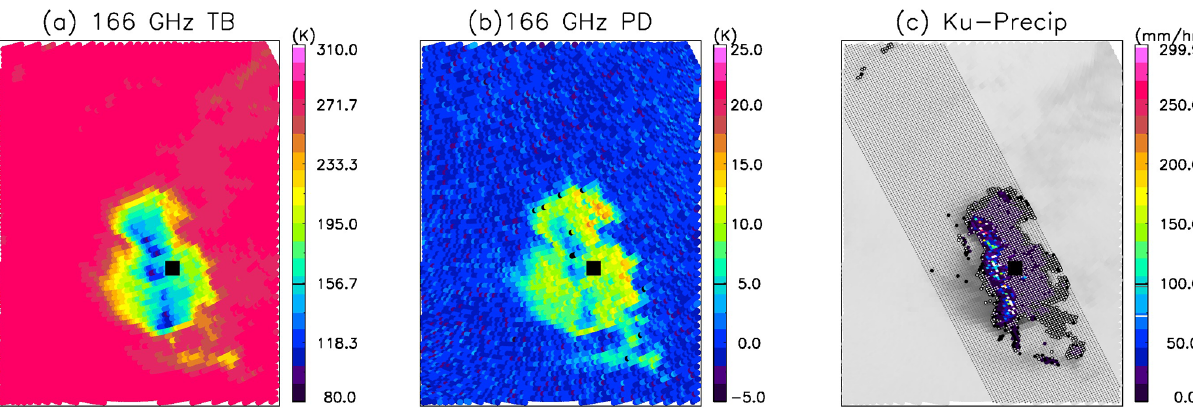
Figure 8. A squall line case captured by GMI and DPR exhibits larger PD behind (to the right) the deep convective front than in the leading edge (to the left). (a) The 166GHz TB, (b) 166GHz PD and (c) KuPR retrieved surface precipitation rate (color) on DPR swath (grey) overlaid on top of GMI 166GHz PD (light grey), where convective pixels are colored and stratiform pixels are stippled with white circles. The black rectangle is a reference point for easy inter-panel comparison. This squall line case occurred on 20 July 2015 (orbit no. 007908) over Chad, Africa.